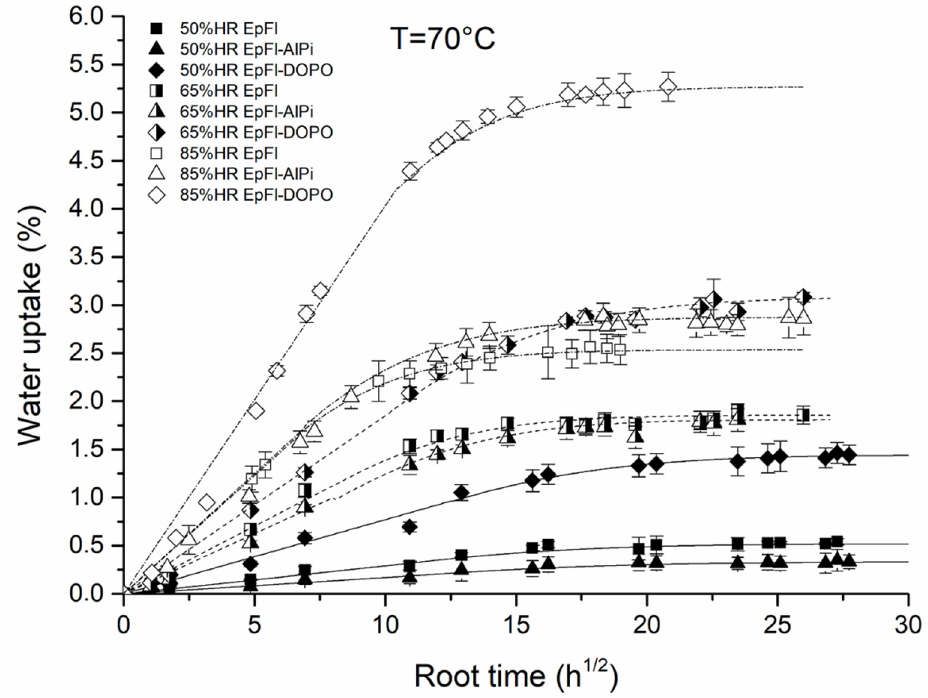
Figure 1. Water sorption kinetics at 70 °C in humid atmosphere for EpFl, EpFl-AlPi and EpFl-DOPO.